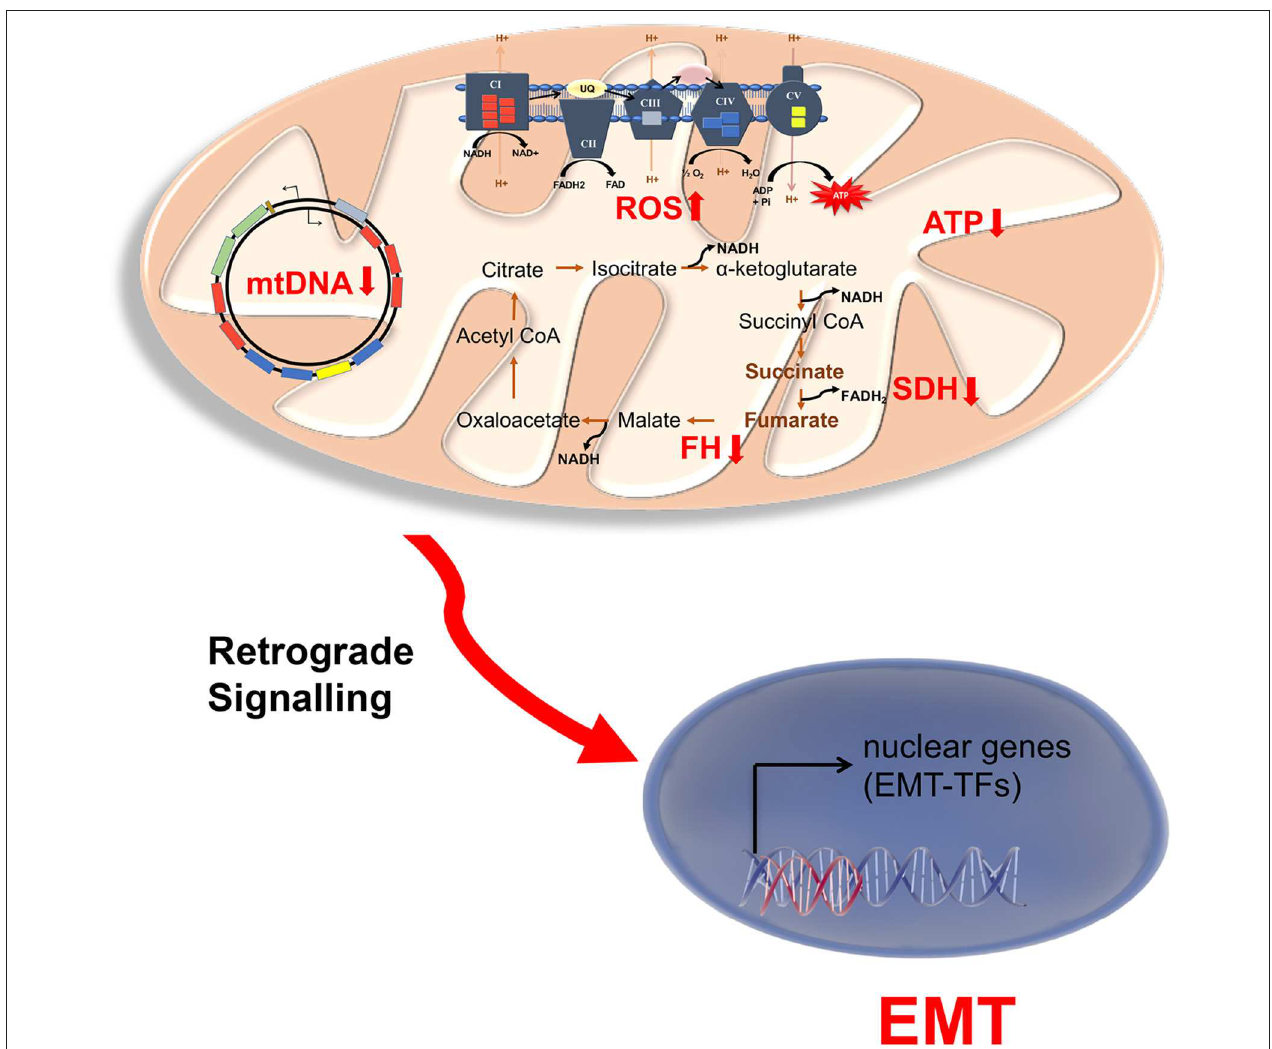
FIGURE 2 | Mitochondrial dysfunction in endocrine cancers. Schematic representation of mitochondrial disruptions associated with EMT in endocrine cancers. NADH and FADH 2 produced in the TCA cycle is utilized by electron transport chain (ETC) to produce ATP for Oxphos. As mitochondrial encoded genes are limiting for Oxphos, mutation in mitochondrial DNA (mtDNA) also causes low mitochondrial ATP and increased ROS (reactive oxygen species) production. The increase production of ROS and/or mutation in the TCA cycle enzymes succinate dehydrogenase (SCD) and fumarate hydratase (FH) result in accumulation of succinate and fumarate. These might be involved in retrograde signaling to activate nuclear EMT transcription factors, particularly in neuroendocrine cancers pheochromocytoma and